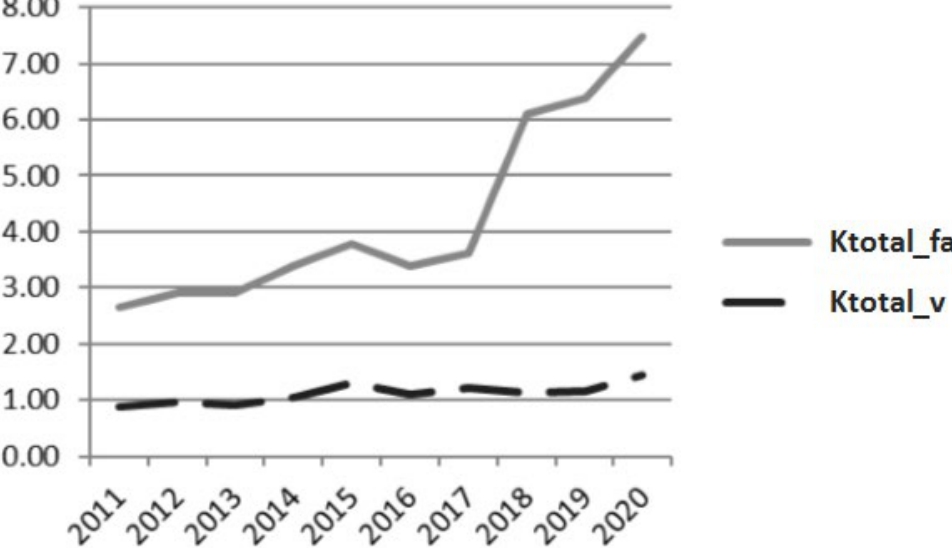
Figure 14. Ktotal value dynamics for Freeport-McMoRan Inc. Ktotal_fa—Ktotal for the total fixed assets; Ktotal_v—Ktotal for the total cost of machinery and equipment. Ktotal_fa and Ktotal _v were calculated based on the initial fixed assets, intangible assets, and R&D costs.